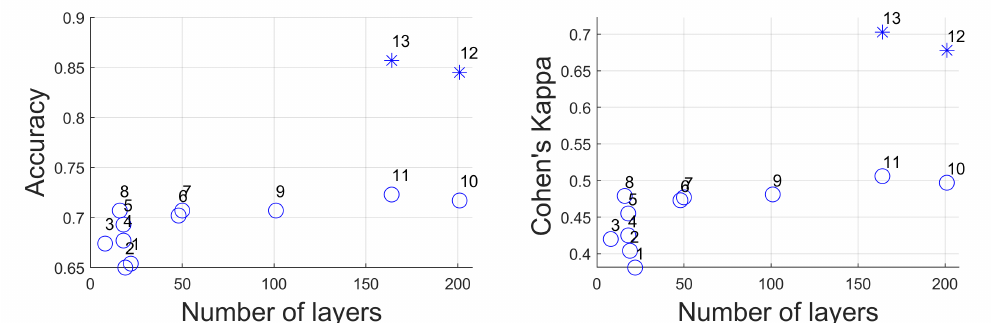
Figure 12. Illustration of the effect of the number of layers of architectures against the two metrics used in this paper Accuracy and Cohen’s Kappa. Each architecture is represented by a circle, except those with augmentation that are represented by an asterisk. For visualisation purposes, numbers are added and these correspond to the order of Table 7 (1 GoogleNet, 2 VGG-19, 3 AlexNet, 4 SqueezeNet, 5 ResNet-18, 6 Inception-v3, 7 ResNet-50, 8 VGG-16, 9 ResNet-101, 10 DenseNet-201, 11 Inception- ResNet-v2, 12 ResNet-50 (augmentation), 13 Inception-ResNet-v2 (augmentation)). Notice the slight improvement provided by deeper networks and the significant improvement that corresponds to data